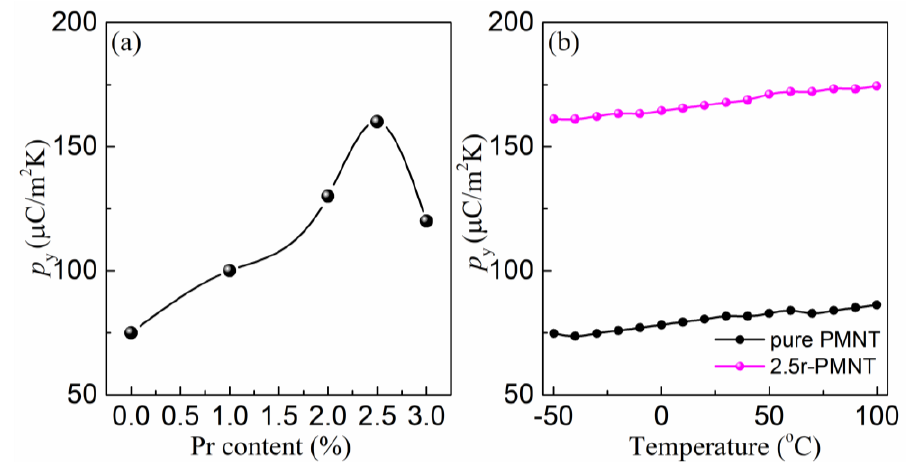
Figure 6. ( a ) Pyroelectric coefficient ( p y ) dependent of Pr content in Pr-PMN-PT thin film annealed at 650 °C for 2 min; ( b ) pyroelectric coefficient ( p y ) measured in pure PMN-PT and 2.5% Pr-PMN-PT thin films at temperature between −50 °C and 100 °C.